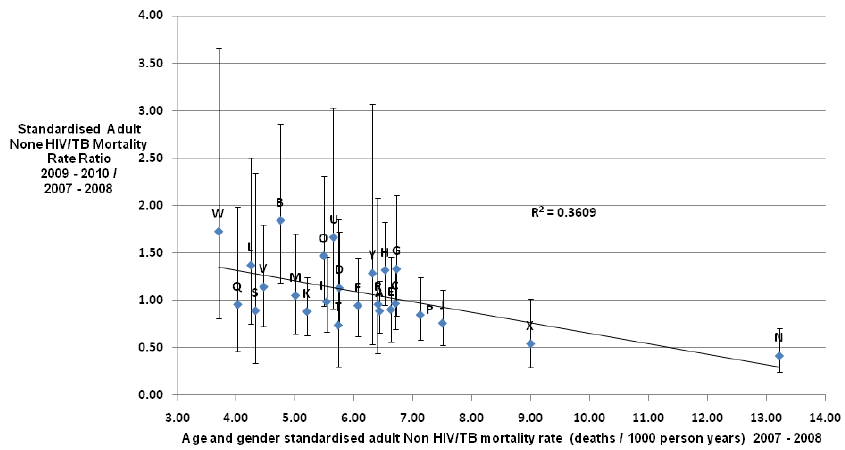
Figure 4. A comparison of the Non HIV/TB mortality rate ratios (with 90% confidence intervals) and mortality rates for 2007–2008 (points are labelled with the village codes). The best fit trend line is superimposed on the points with the associated R–squared